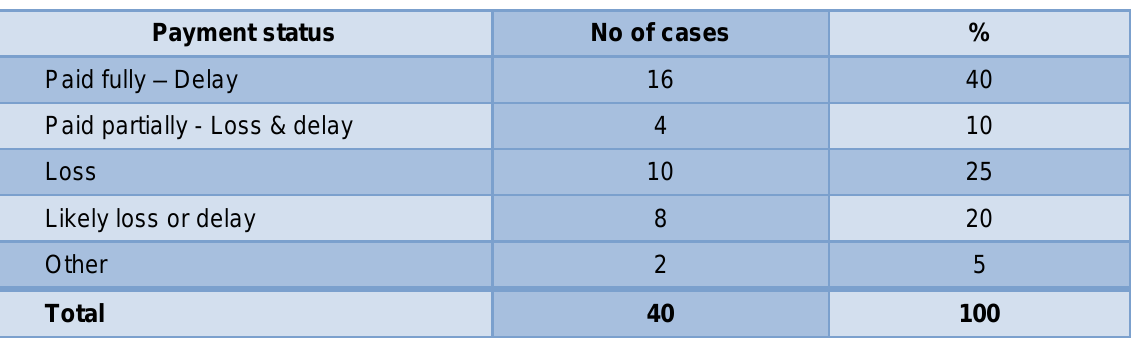
Table 3 Status of payment disputes Strategies Used to Tackle Payment Delays and